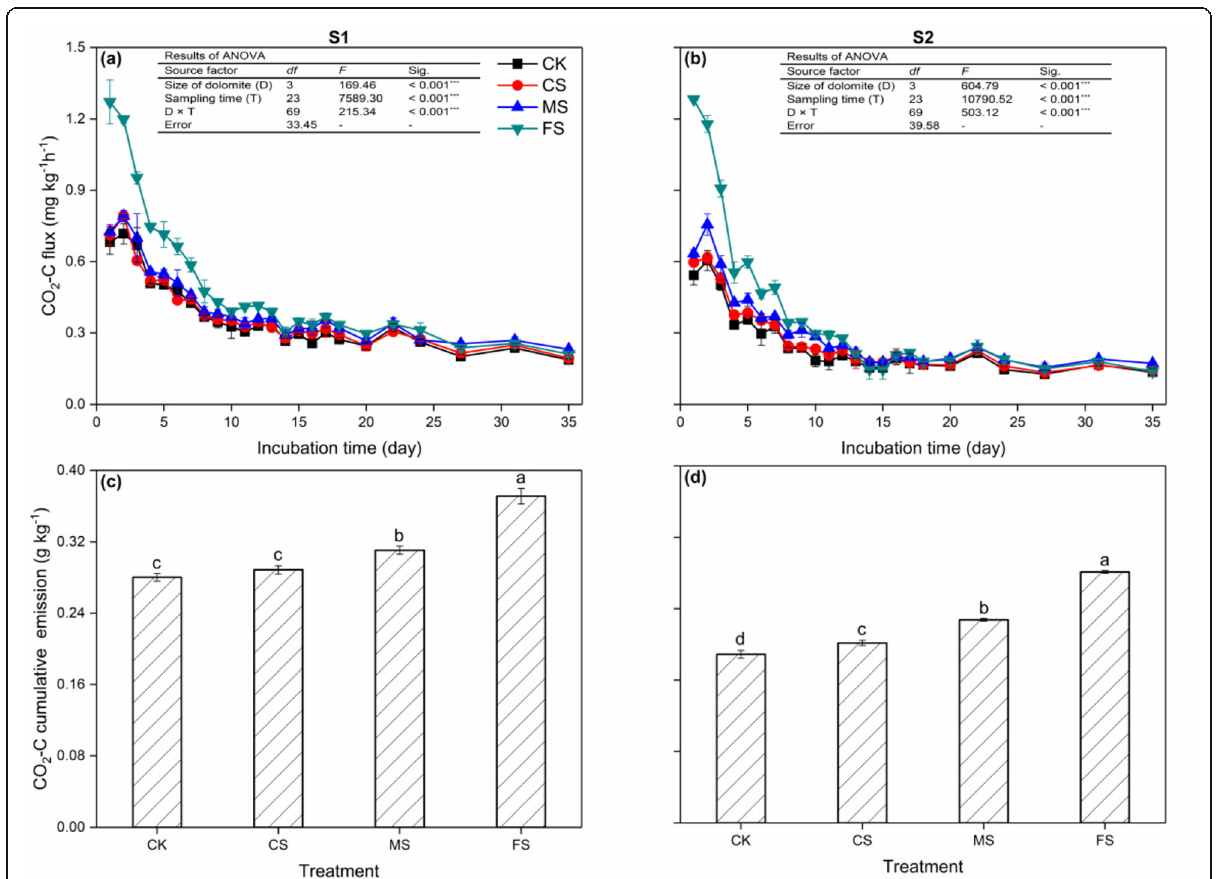
Fig. 3 CO 2 -C emission fluxes and cumulative emissions at the end of incubation (day 35) in S1 ( a , c ) and S2 ( b , d ) as affected by different sized dolomite application. Error bars represent standard deviation of the mean values ( n = 3). *** P < 0.001. Different letters above bars denote significant differences between treatments (LSD test, P < 0.05). See Fig. 1 for abbreviations of dolomite treatments and statistic